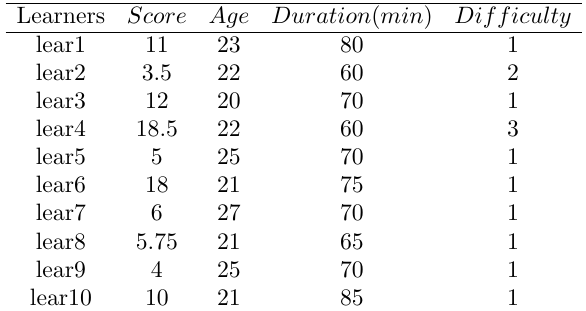
Table 1. Extract of learners